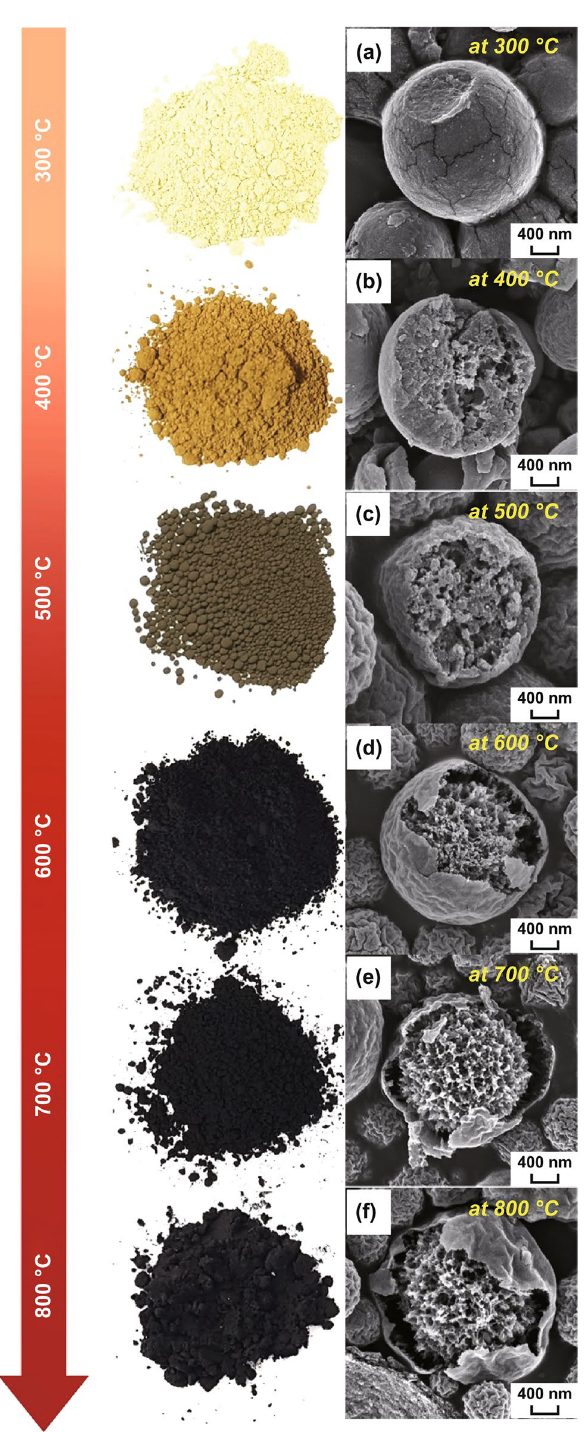
Fig. 1 Morphologies of the as‑prepared powders obtained by spray pyrolysis at different temperatures: a 300 °C, b 400 °C, c 500 °C, d 600 °C, e 700 °C, and f 800